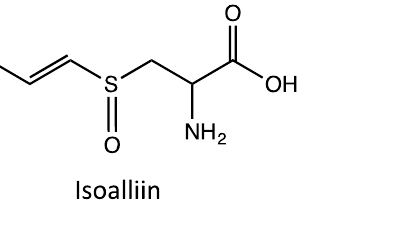
Figure 1. Alliinase pathway: Production of sulfur-containing secondary metabolites upon cutting garlic tissue.